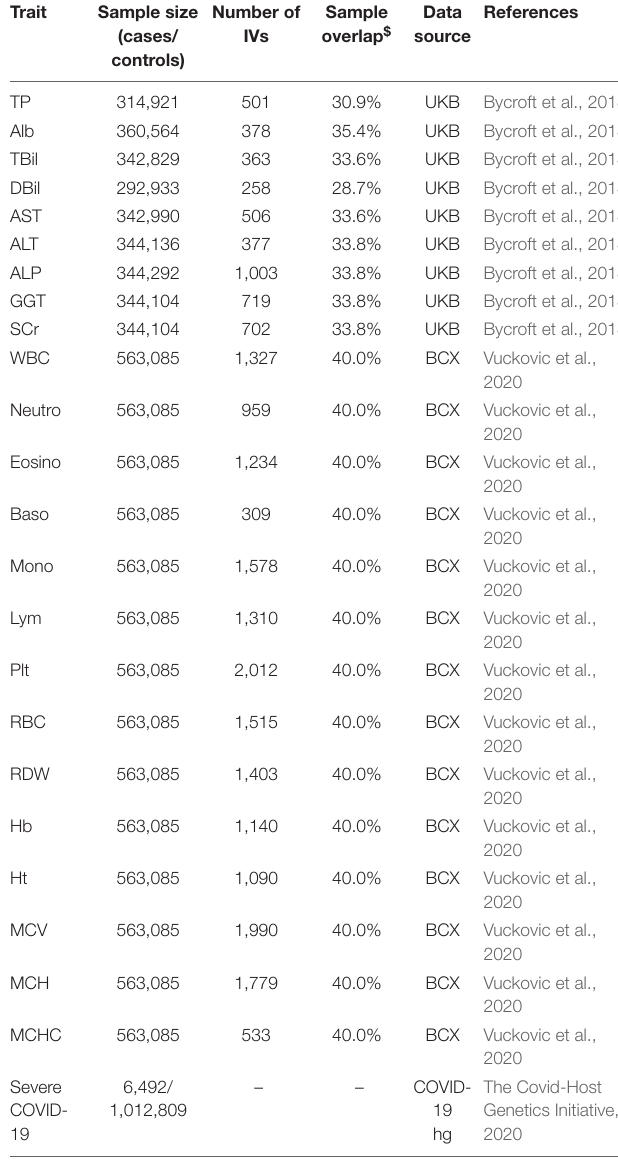
TABLE 1 | Description of GWAS information for 23 risk factors and severe COVID-19 in this